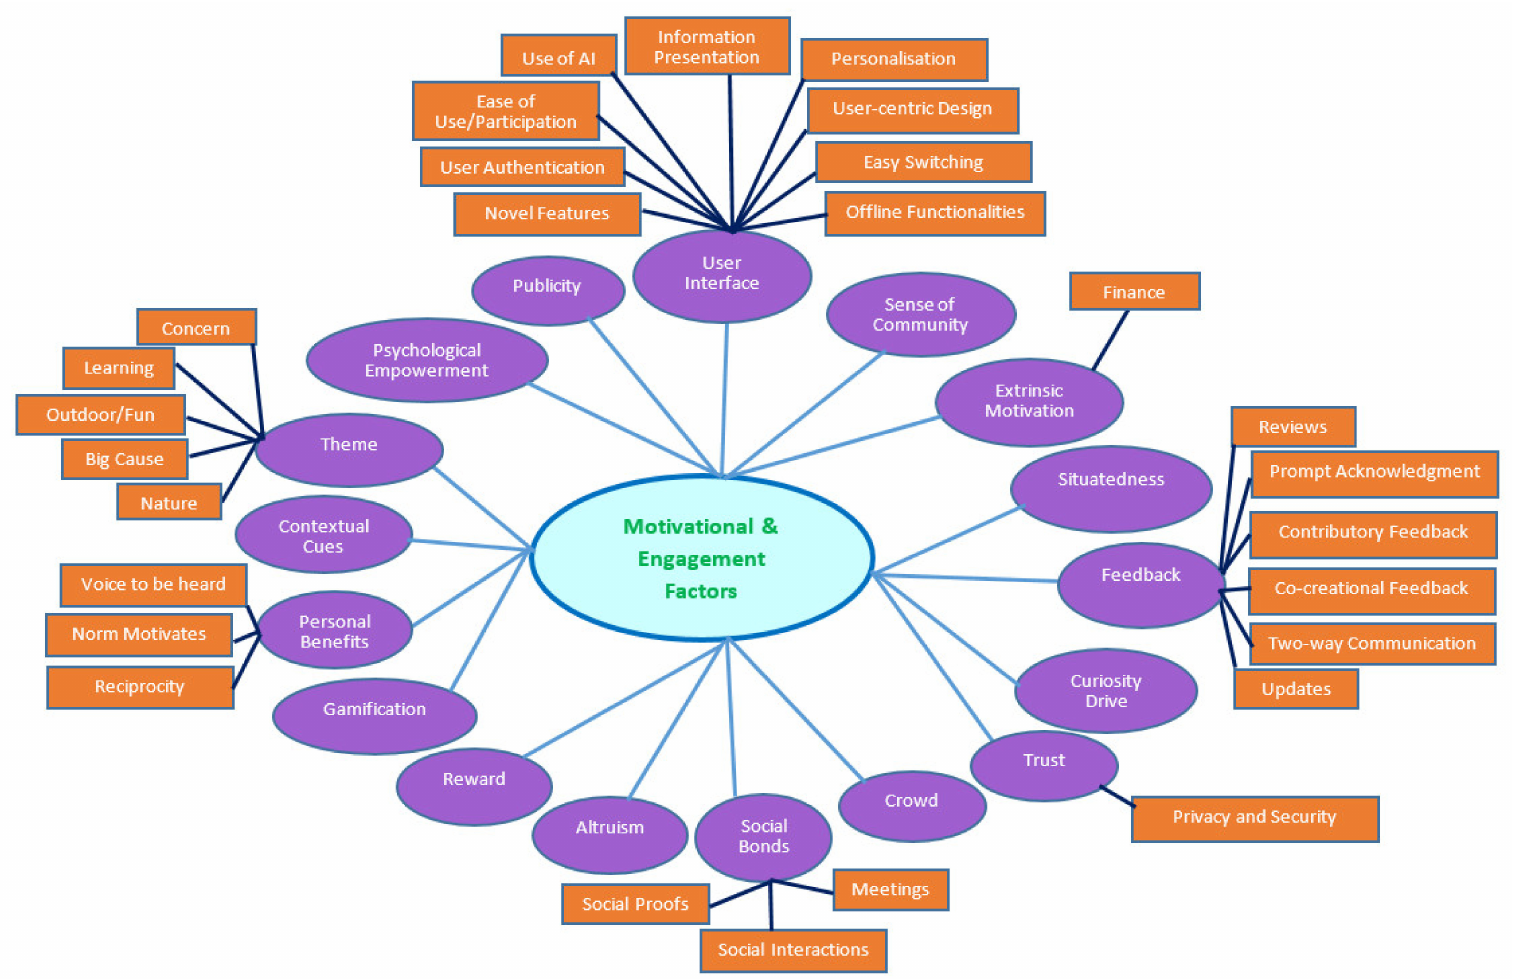
Figure 2. Motivation and Engagement Factors